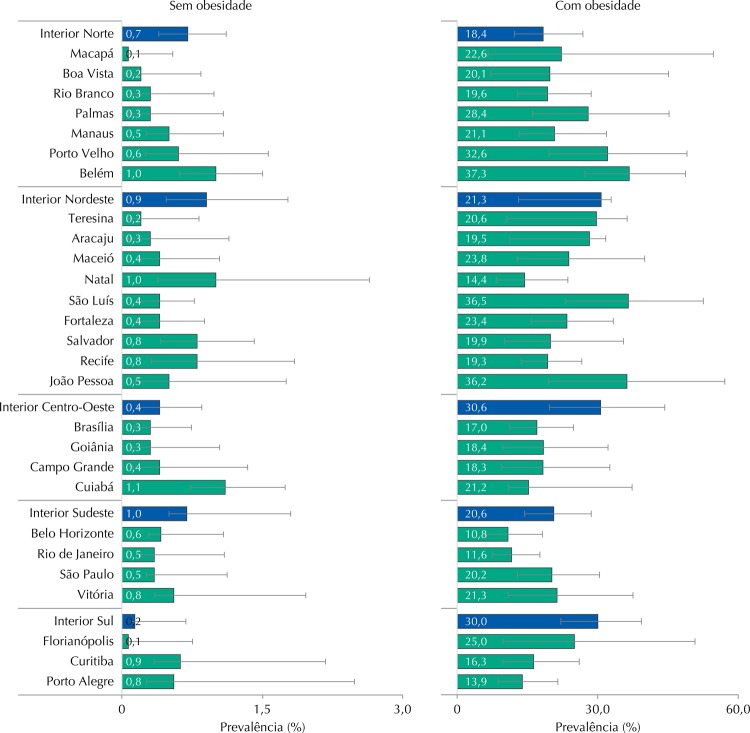
Prevalências (%) e IC95% de síndrome metabólica em adolescentes sem obesidade e com obesidade segundo estratos de capitais e do interior das regiões. ERICA, Brasil, 2013-2014.